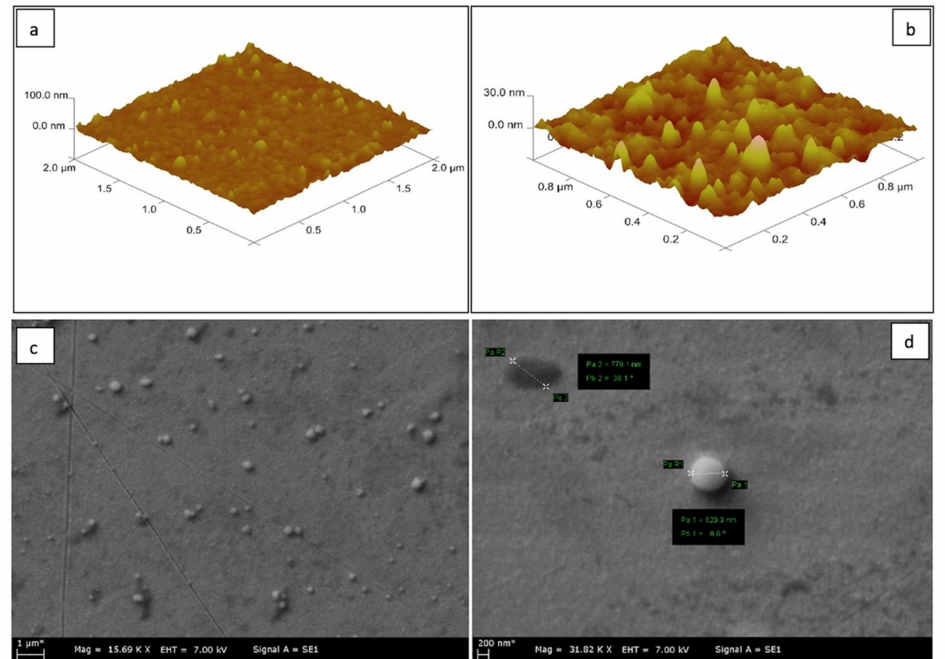
Figure 2. Characterization of S. aureus -imprinted SPR sensor chips with AFM and SEM. AFM image of S. aureus -imprinted SPR sensor chips, scanning area of 2 µ m × 2 µ m ( a ), 1 µ m × 1 µ m ( b ), SEM images of S. aureus -imprinted SPR sensor chips ( c , d